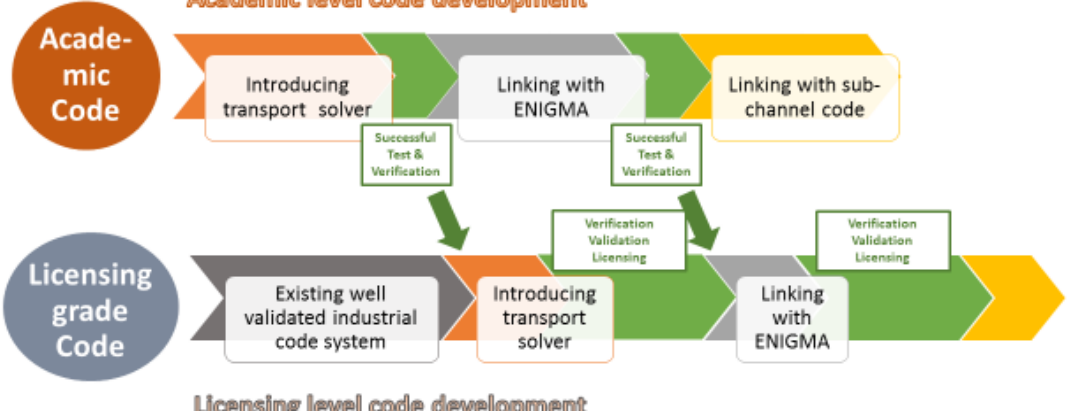
Figure 5. The double-strata approach for the parallel development of an academic prototype and a licensing grade code for industrial applications.